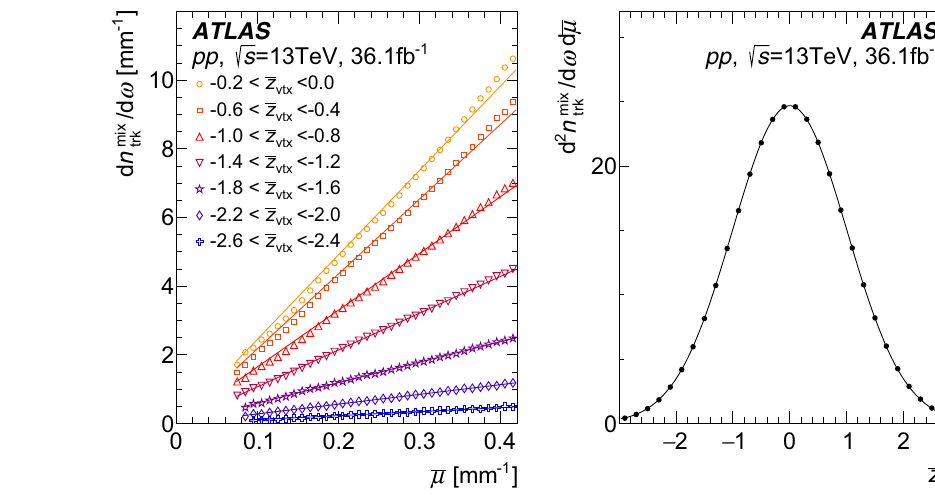
Fig. 3 Left: The number of tracks in Mixed events per mm at ω = 0 as a function of ¯ μ . Different marker colours correspond to selected ¯ z vtx intervals. Not all intervals are shown for figure clarity. Solid lines are